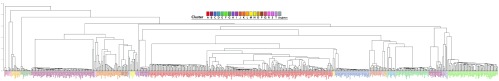
Hierarchical clustering of all 663 phage genomes.Hierarchical clustering dendrogram constructed on pairwise Euclidean distances between all 663 phages in the mycobacteriophage database. In almost every case, phages are placed in a monophyletic clade with members of their subcluster, highlighting the concordance between alignment-based and alignment-free methods for comparison for these genomes. Some clusters (F, C, D, M and L) form monophyletic clades, while others (B, for example) are grouped in different parts of the dendrogram. A larger version of this figure can be downloaded from
Click here for additional data file..